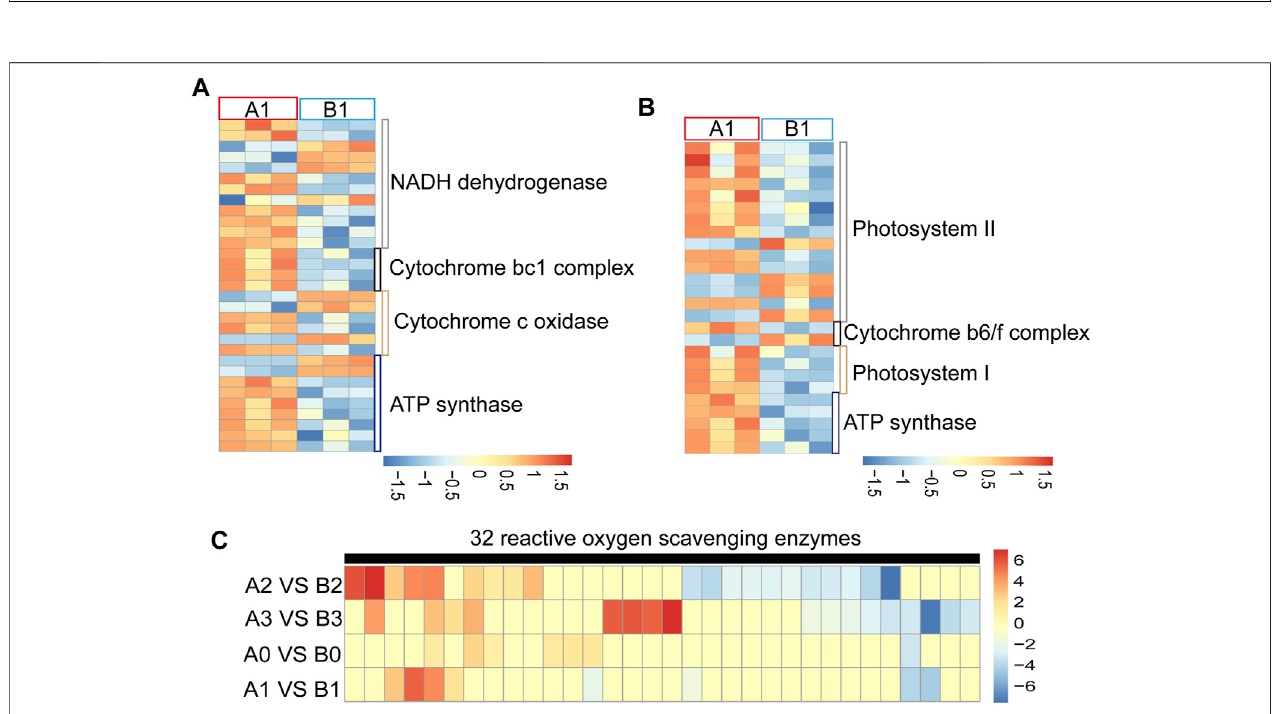
FIGURE 2 | Expression analysis of DEGs involved in electron transport chain and ROS scavenging enzymes. (A) Expression analysis of DEGs in mitochondrial electron transport chains of AL18A and AL18B in uni-nucleate stage. (B) Expression analysis of DEGs in chloroplasts electron transport chains of AL18A and AL18B in uni-nucleate stage. (C) Expression analysis of DEGs in ROS scavenging enzymes of AL18A and AL18B in different anther development stages.